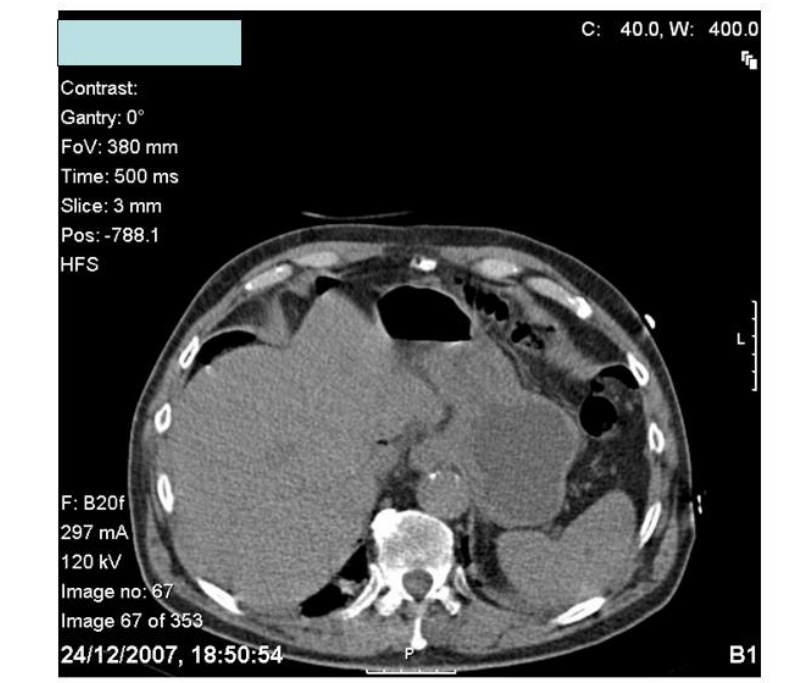
FIGURE 4. CT scan of the abdomen showing pneumoperitoneum.